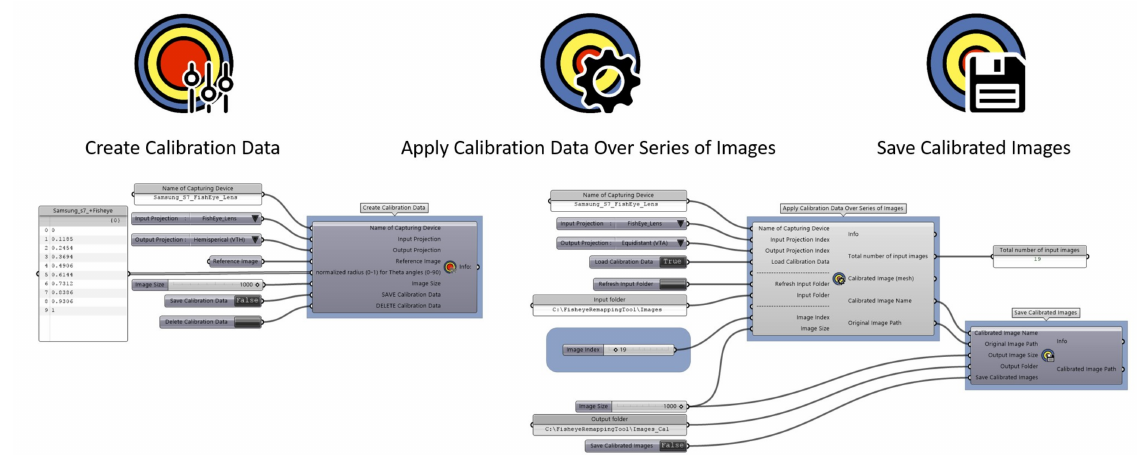
Figure 8. Shows the Fisheye Remapping Tool as a Grasshopper